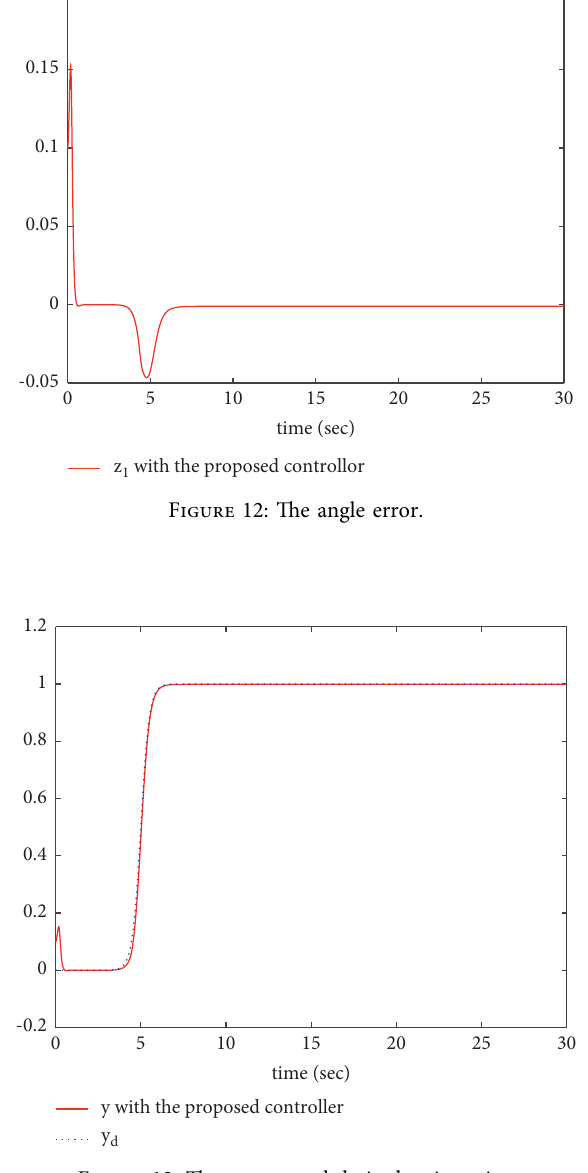
Figure 13: The output and desired